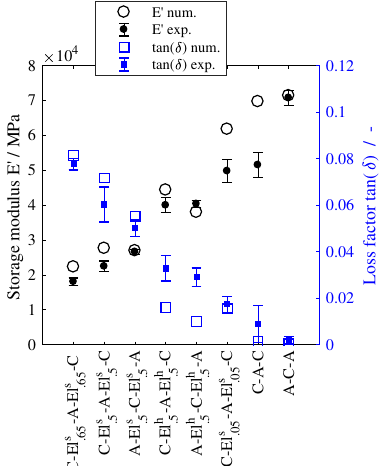
Figure 11. Comparison of experimental and numerical results for 20 ◦ C and 1Hz in ascending order of the experimentally determined storage modulus. Three specimens for each lay-up.